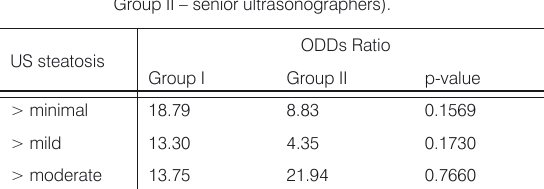
Table 2. The prognostic value of US examination for the assessment of steatosis according to the experience of the